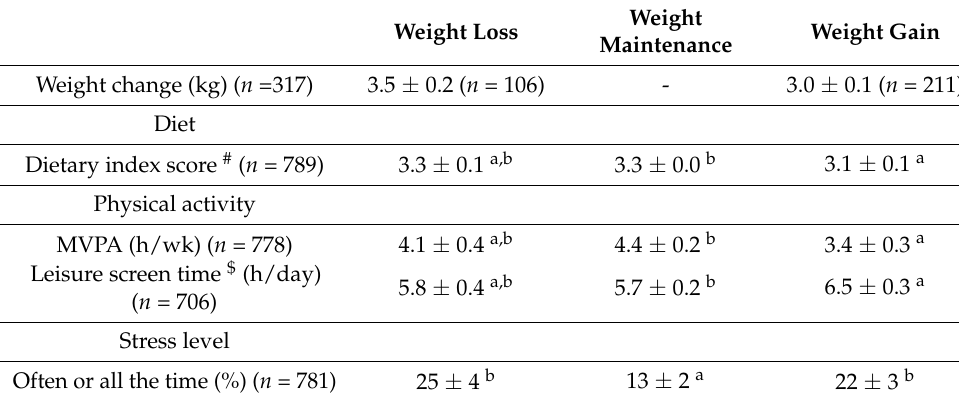
Figure 2. Change in body weight during the first lockdown period among Danish adults ( n = 789). Table 5. Weight change among Danish adults during the lockdown period and differences in diet, physical activity, and stress level according to change in body weight using descriptive statistics (mean/percentage ± SEM).